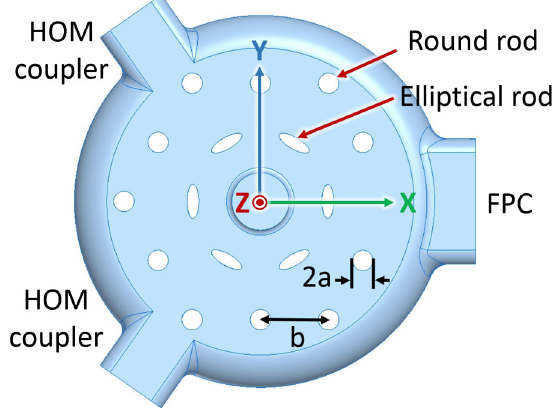
FIG. 3. PBG cell as seen from the Z axis pointing along the beam trajectory. The vacuum region is shown in blue.